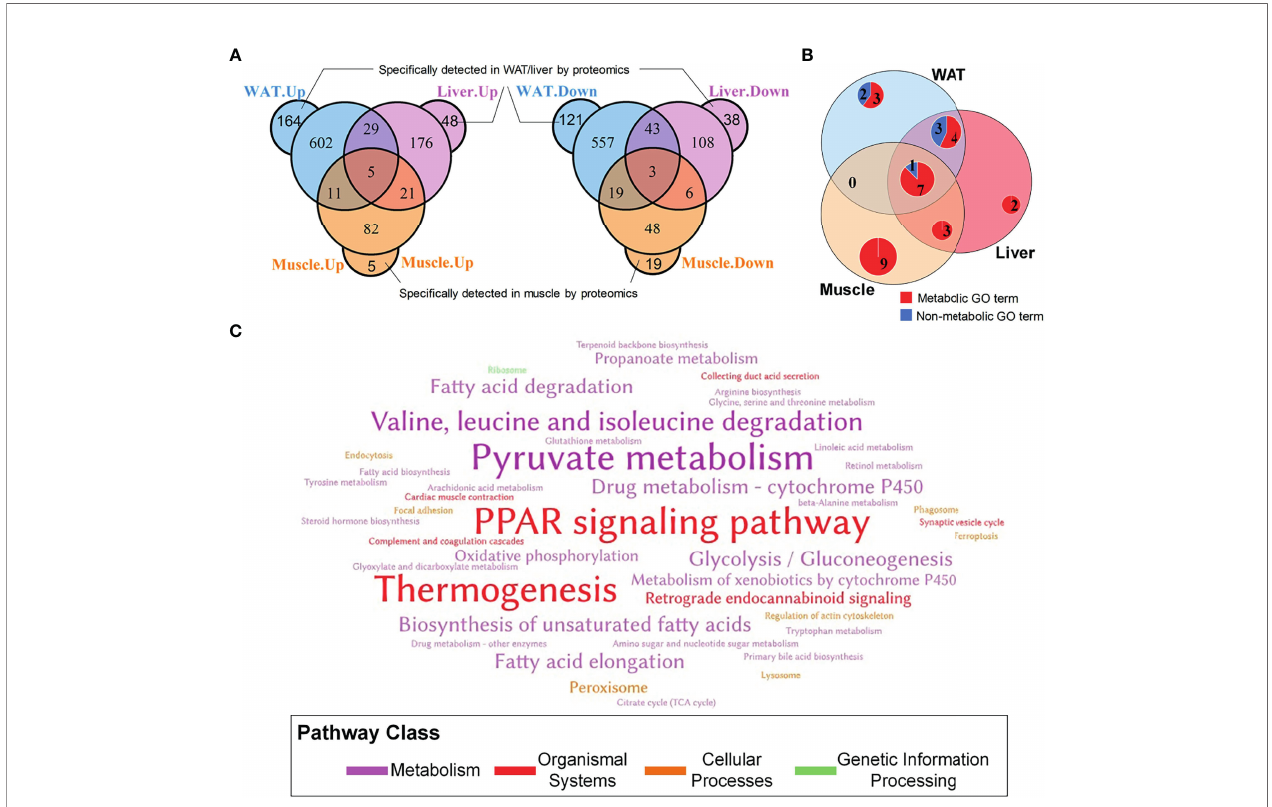
FIGURE 2 | General information of DEPs in WAT, liver and skeletal muscle. (A) Overlapping of differential proteins; (B) Coincidence of TOP20 enriched GO terms, where the TOP20 GO terms with the lowest FDR in distinct tissue were graphed; (C) Word cloud of KEGG pathways enriched by tissue-speci fi c protein pro fi les. The words with the largest font size represent pathways simultaneously enriched by three tissues; the words with medium font size represent pathways commonly enriched by two tissues; and the words with small font size represent pathways only enriched by one